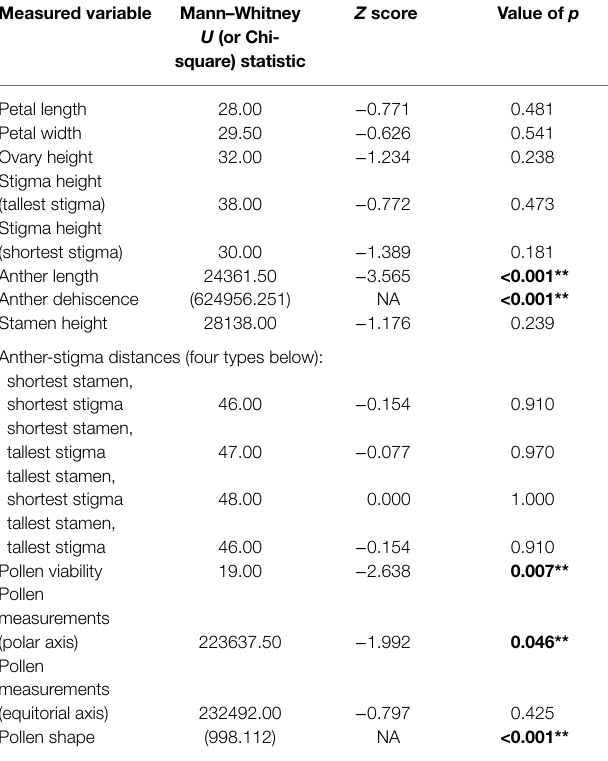
Values considered to be significantly different are represented with ** as well as bolded.